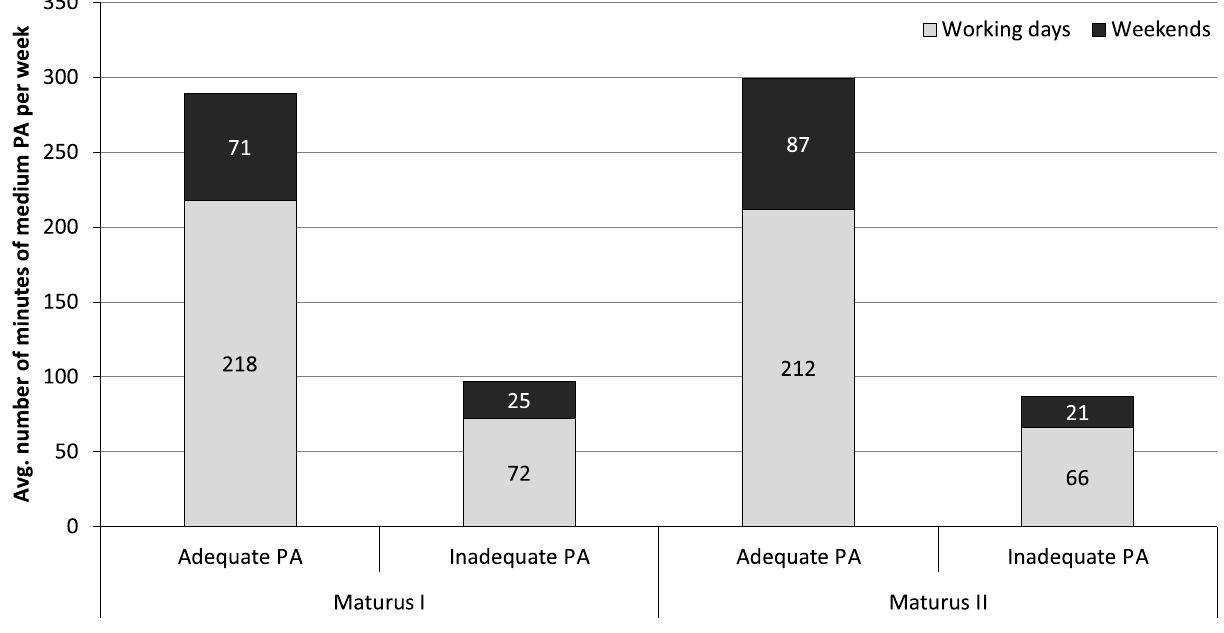
Figure 1. Comparison of weekly medium PA (3 to 6 MET) in women groups